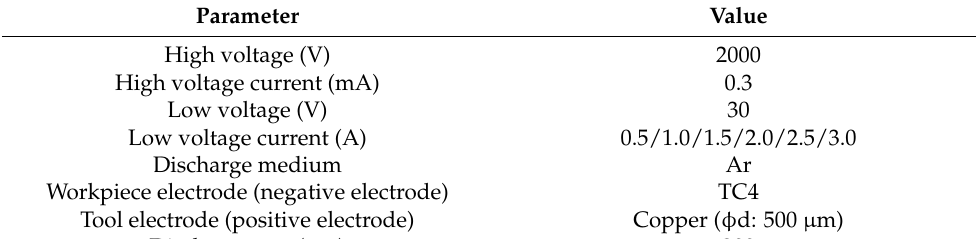
Table 4. Machining parameters of high voltage-induced weak arc discharge.